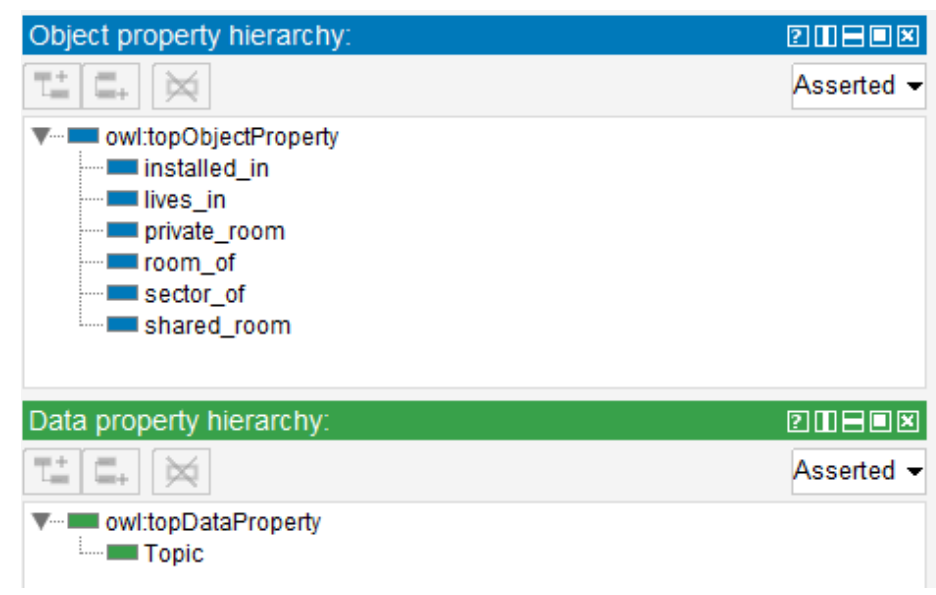
Figure 14. Household ABC digital twin ontology.